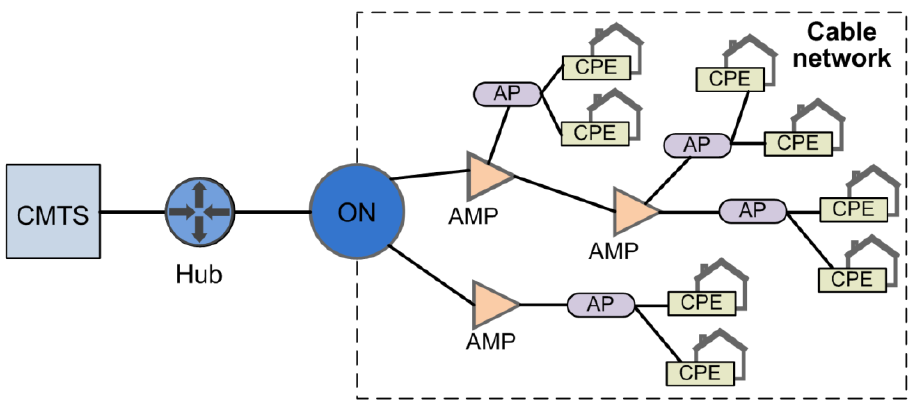
Figure 1. HFC network. CMTS: Cable Modem Termination System, ON: Optical Node, AP: Access Point, CPE: Customer Premises Equipment, AMP: Amplifiers.